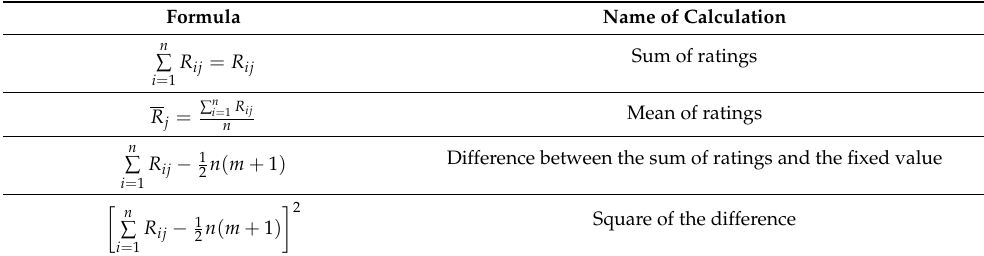
Table 4. Formulas for calculating ranks (source: compiled by authors based on)